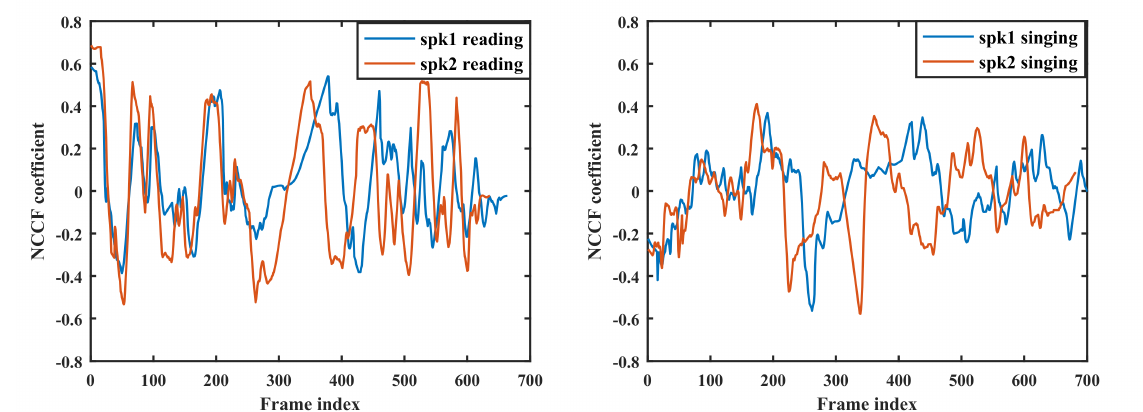
Figure 2. NCCF pitch contour of reading ( left part ) and singing ( right part ) speech between two females with the same